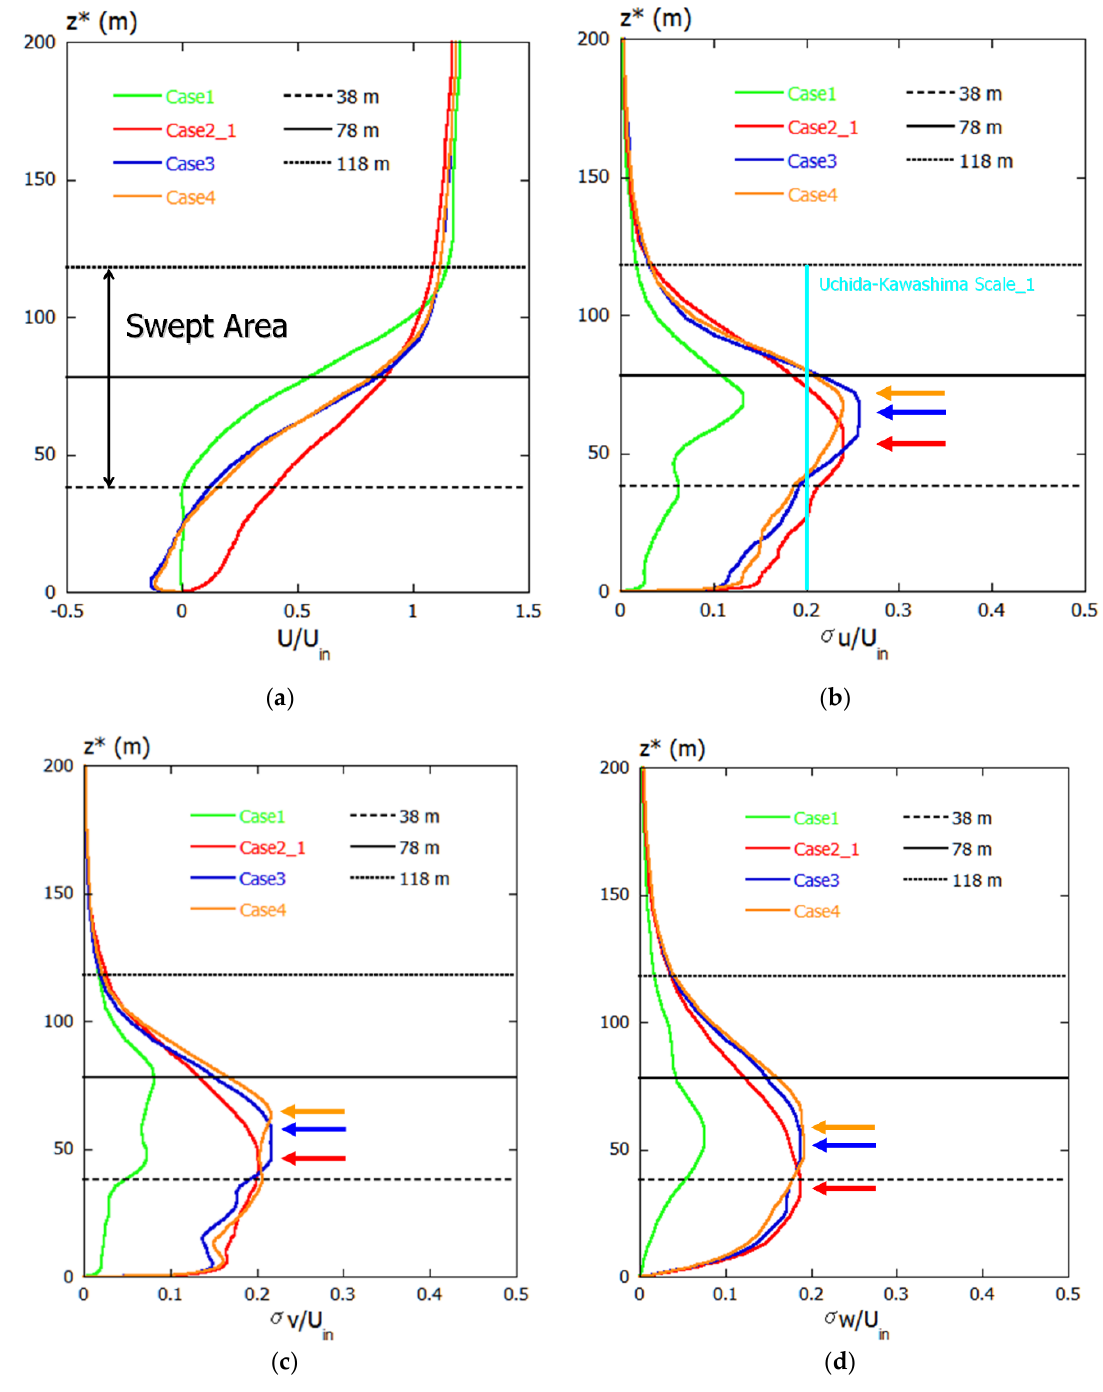
Figure 15. Vertical profiles of statistical quantities. ( a ) Normalized mean streamwise wind velocity, ( b ) normalized standard deviation in the streamwise direction, ( c ) normalized standard deviation in the spanwise direction, and ( d ) normalized standard deviation in the vertical direction. U in : the inflow streamwise wind velocity at the height of the maximum surface elevation in the computational domain; z* (m): the height above the ground.